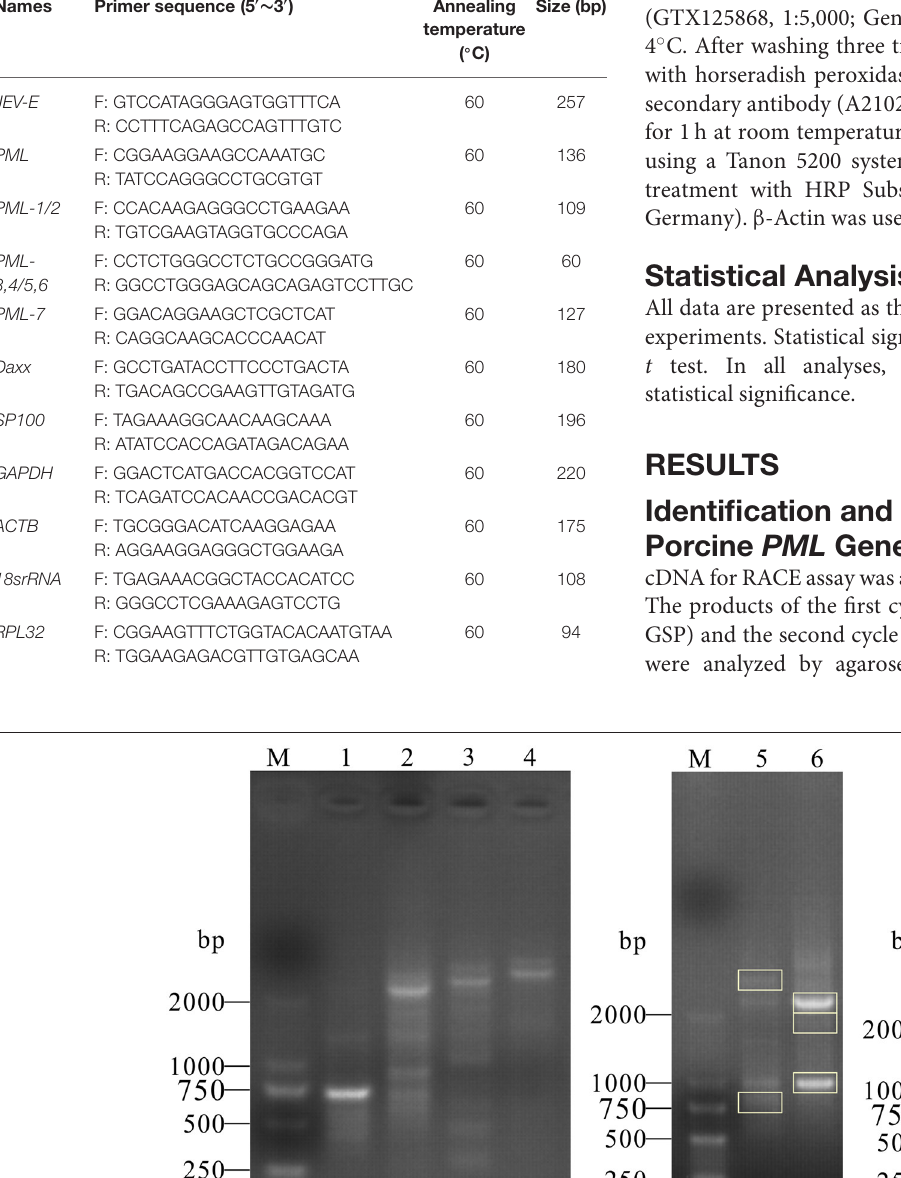
Frontiers in Veterinary Science |